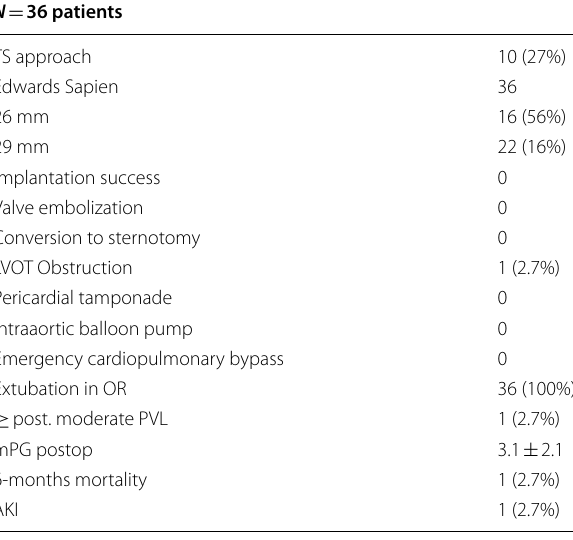
N, number; SD, standard deviation; AKI, acute kidney injury; PVL, paravalvular leak; OR, operation theater; mPG, mean pressure gradient, TS, transseptal